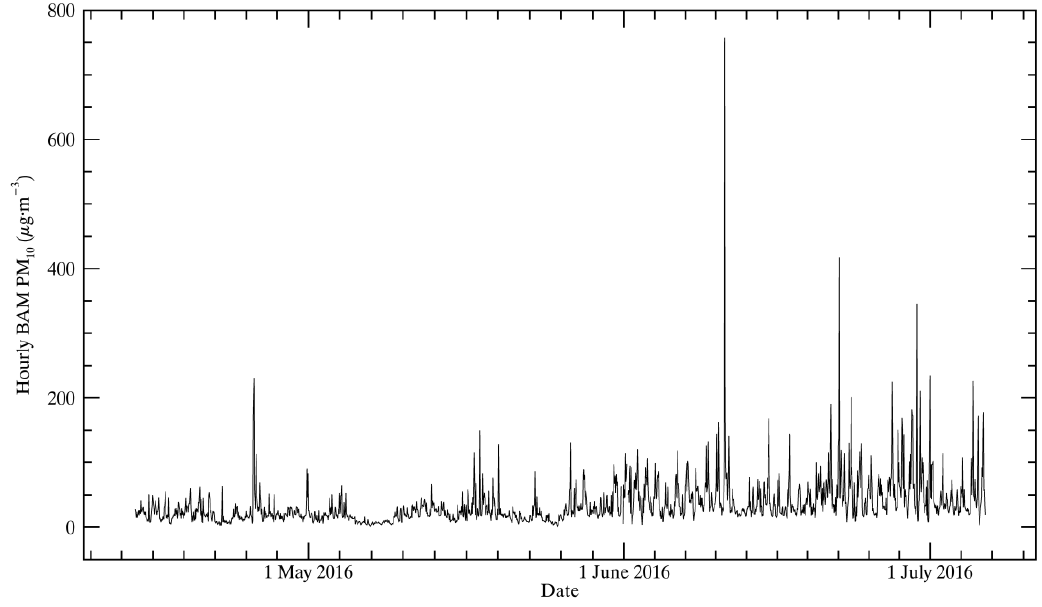
Figure 3. Hourly PM 10 concentrations measured by the beta attenuation monitor (BAM)-1020 from 14 April 2016, to 6 July 2016.